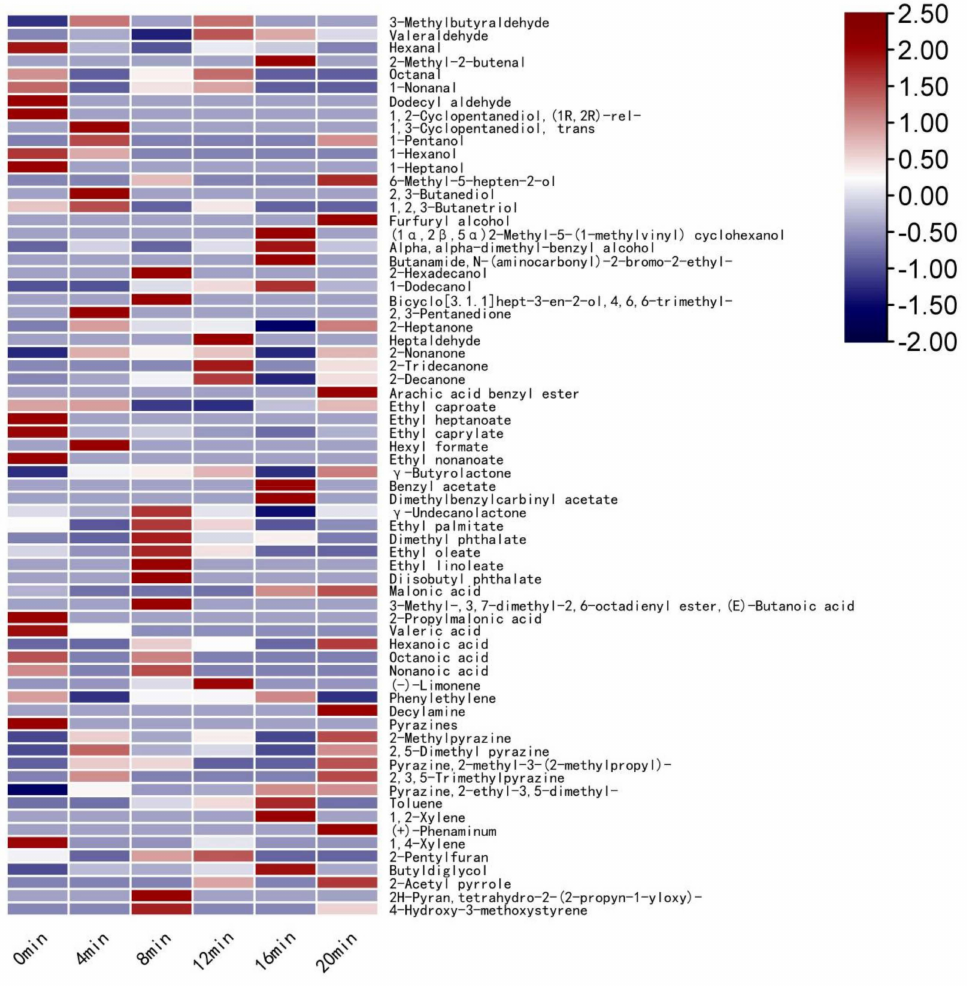
Figure 2. Heat map of volatile compounds in defatted tiger nut